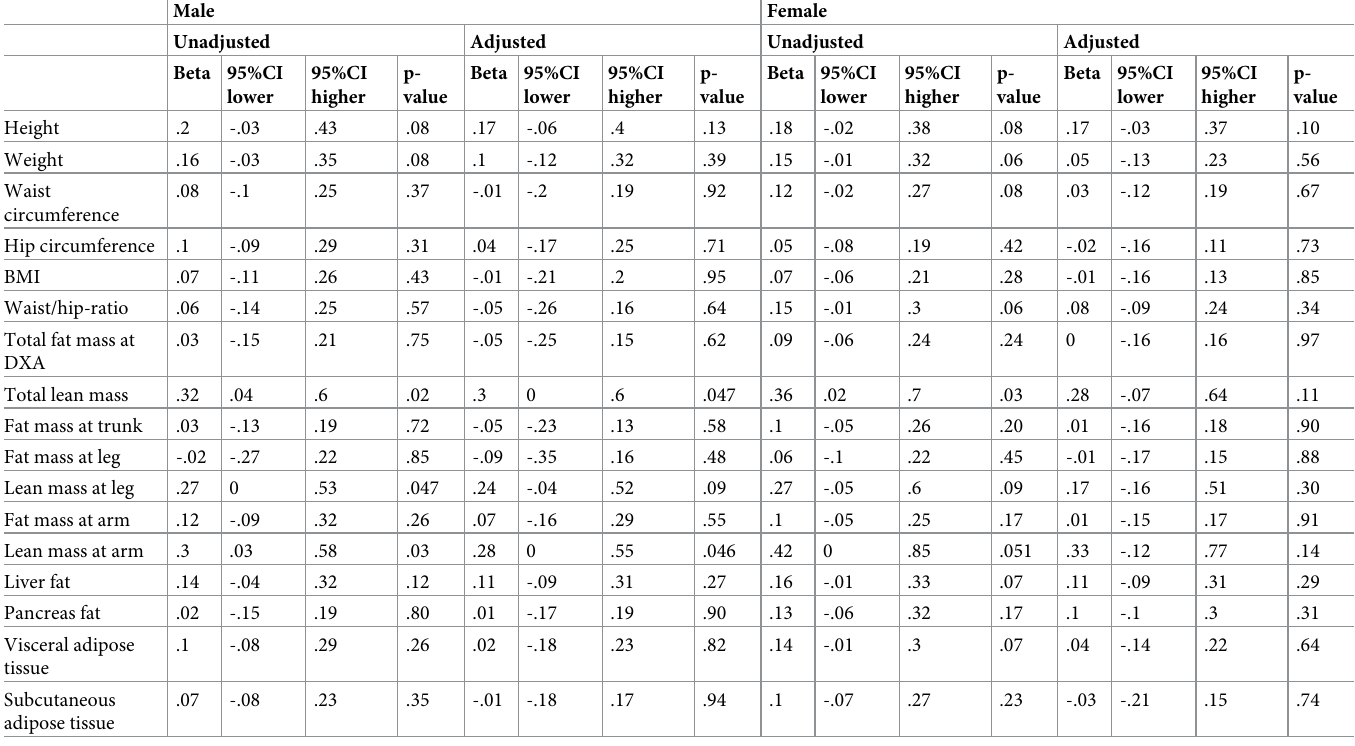
Table 2. Relationships between intima-media thickness (IMT) and traditional measurements of body